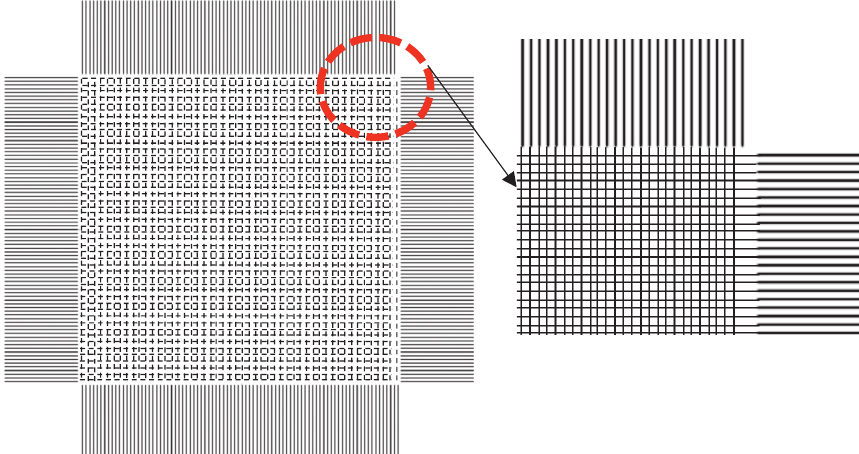
Figure 3: Intersection crosswalk grid in the video.